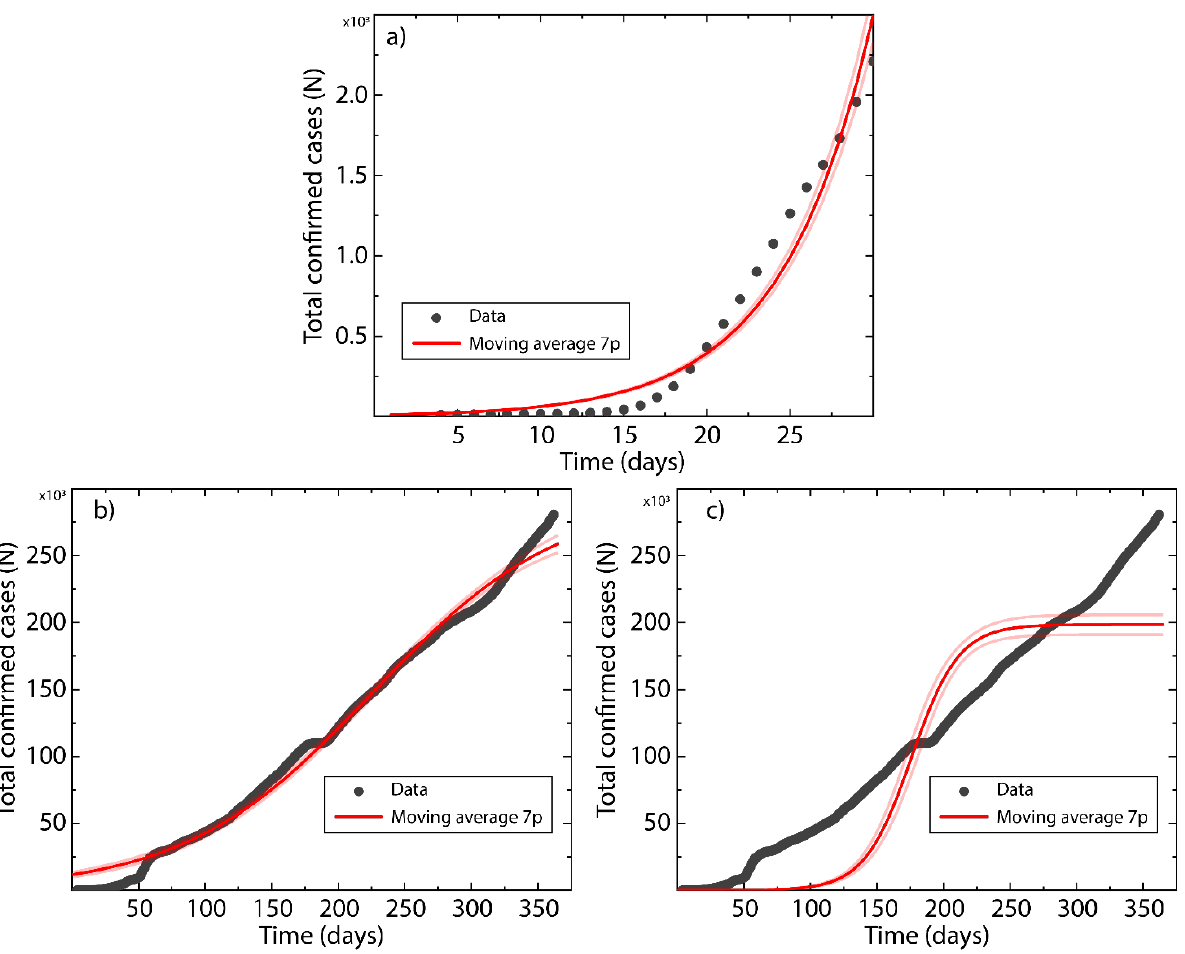
Figure 5. The total number of cases as a function of time fitted with different models: a) exponential model (Equation 5), b) discrete logistic equation (Equation 8), and c) solved ODE logistic equation (Equation 10). Data and fit are represented in black and red, respectively. Pink lines represent the confidence level